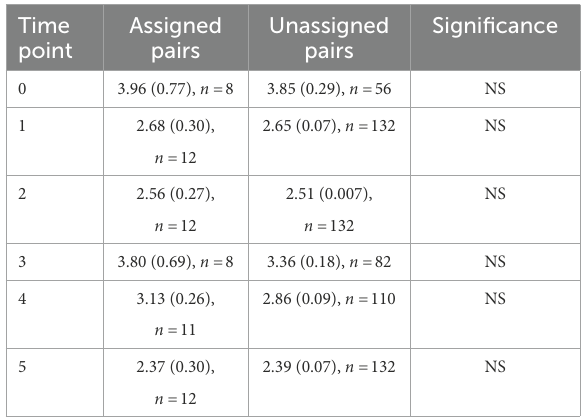
TABLE 4 Mean Euclidean distances of assigned and unassigned pairs, Differences between the two groups were assessed using a t -test, which showed no significance for any time